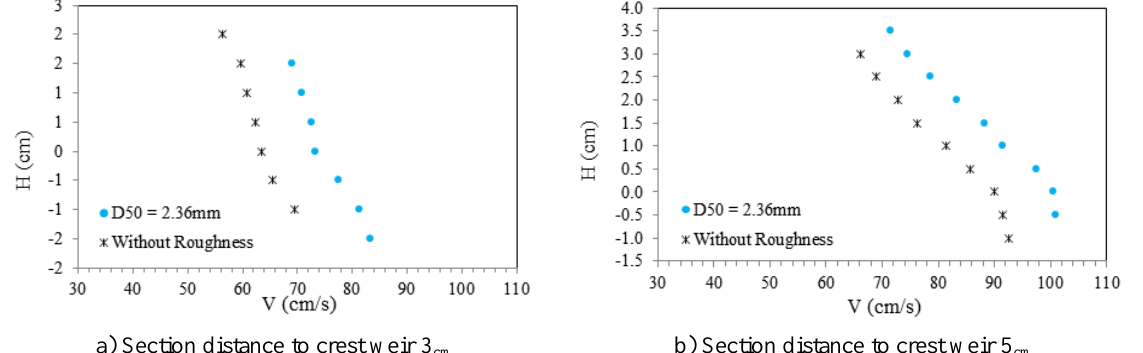
Fig. 9. Velocity profile at different sections after weir crest for different roughness sizes (Q=14 l/s) (H = 0.0 indicates weir crest cm